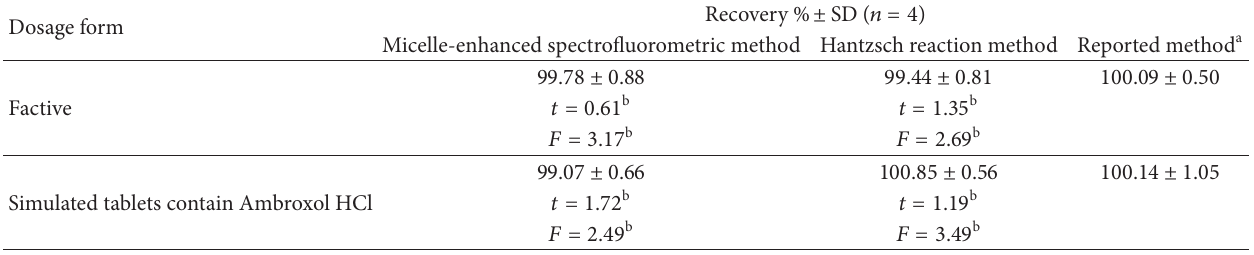
Table 5: Determination of GFX in spiked human plasma samples using the proposed methods. Method